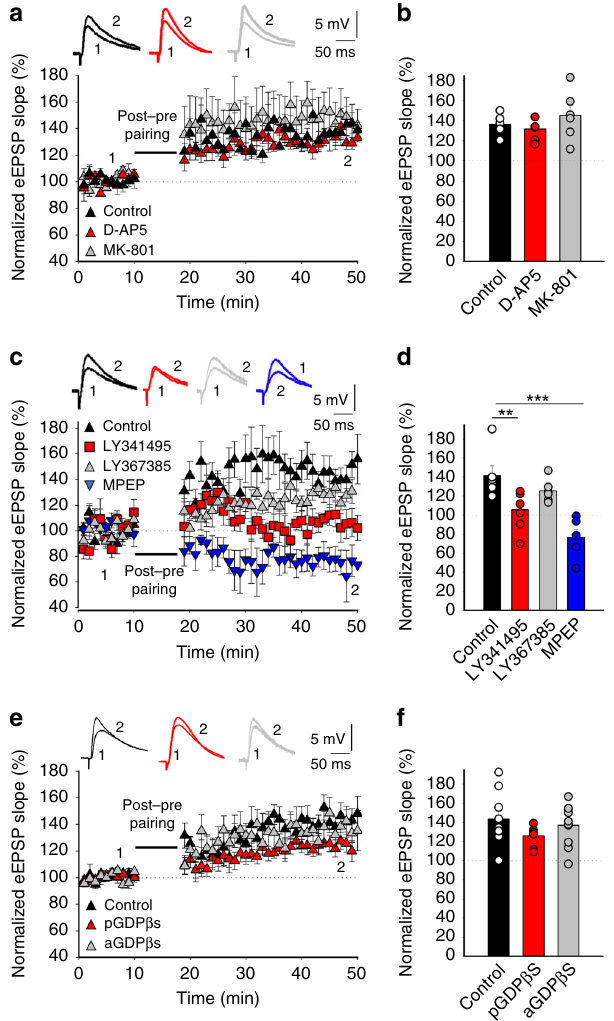
Fig. 3 Presynaptic t-LTP requires metabotropic glutamate receptors but not NMDARs. a Addition of D-AP5 (50 µ M ) to the superfusion fl uid did not prevent t-LTP induction. The EPSP slope is shown in D-AP5-treated (red triangles, n = 6) and untreated cells (black triangles, n = 6). Bath-applied MK- 801 (500 µ M – 1m M ) did not block the induction of t-LTP (gray triangles, n = 6). The traces show the EPSP before (1) and 30min after (2) pairing. b Summary of the results. c The t-LTP requires mGluR5. The EPSP slopes monitored in control slices (black triangles, n = 9) and in slices treated with the mGluR antagonist LY341495 (100 µ M , red squares, n = 6), the group I mGluR antagonist LY367385 (100 µ M , gray triangles, n = 6) or the mGluR5 antagonist MPEP (500 µ M , blue triangles, n = 6) are shown following post-before-pre pairing. The traces show the EPSP before (1) and 30min after (2) pairing. d Summary of the results. e The t-LTP requires activation of presynaptic mGluR5s. Time course of t-LTP induction in control conditions (black triangles, n = 9) and with the postsynaptic neuron (red triangles, n = 6) or astrocytes (gray triangles, n = 10) loaded with GDP β S (1m M ). Inset: Traces show the EPSP before (1) and 30min after pairing (2) in control slices or when the postsynaptic neuron or astrocytes are loaded with GDP β S. f Summary of the results. ** p <0.01, *** p <0.001, one-way ANOVA + Holm – Sidak. Error bars represent the S.E.M. Source data are provided as a Source Data fi